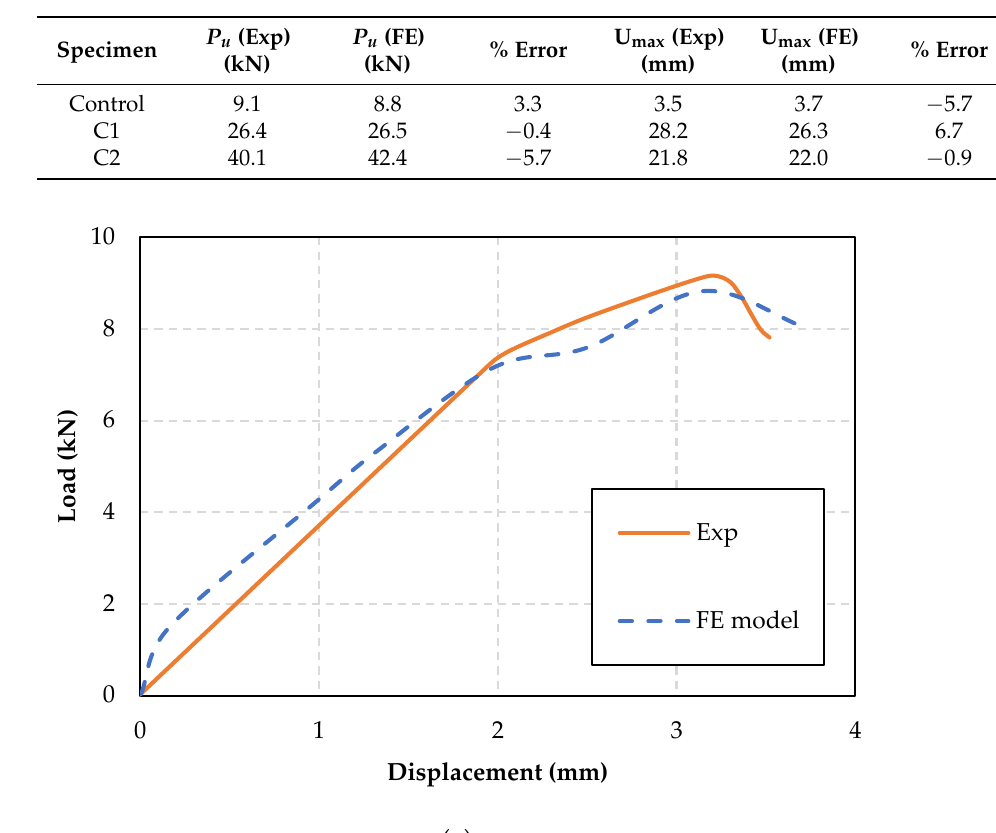
Table 1. Comparison between experimental and FE model’s results.